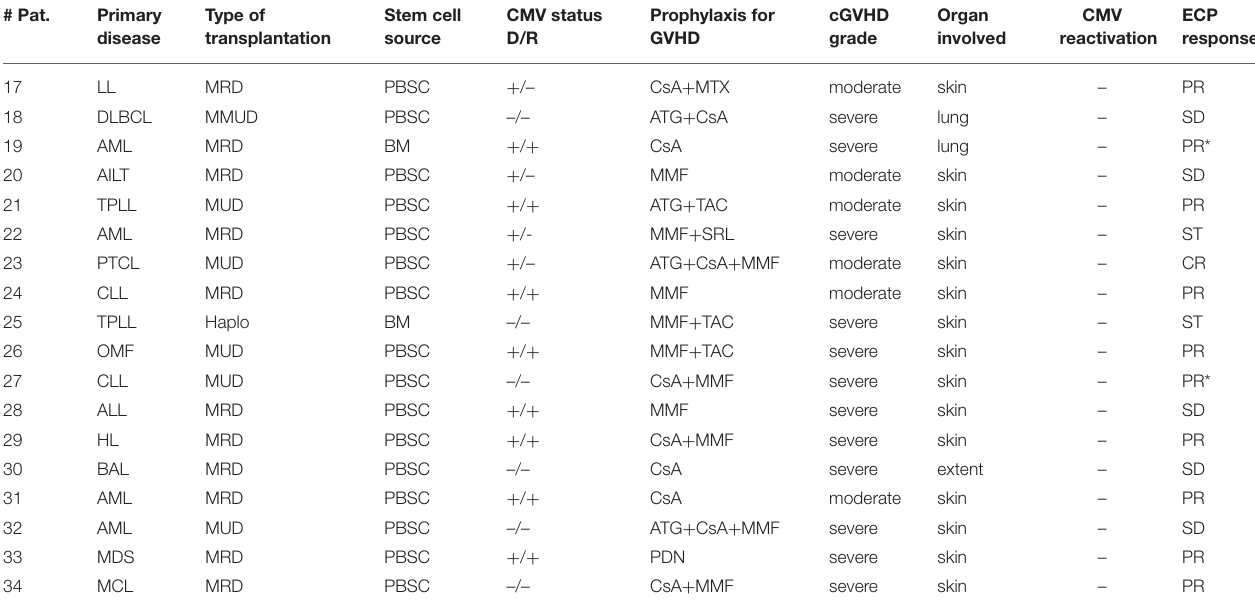
TABLE 2 | cGVHD patients’ characteristics and clinical response to ECP. #